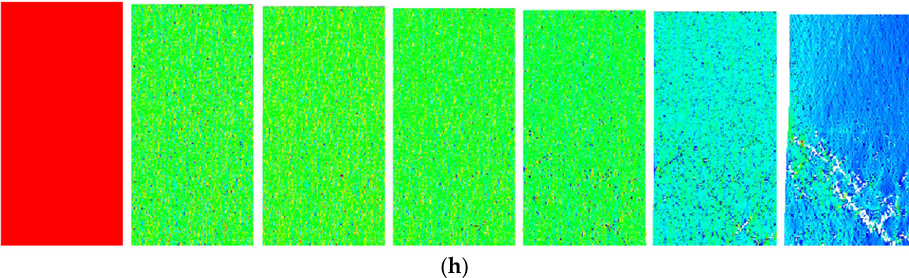
Figure 8. Stress evolution of coal–rock specimens with different prefabricated crack angles: ( a ) θ = 0°; ( b ) θ = 15°; ( c ) θ = 30°; ( d ) θ = 45°; ( e ) θ = 60°; ( f ) θ = 75°; ( g ) θ = 90°; ( h ) intact specimens.